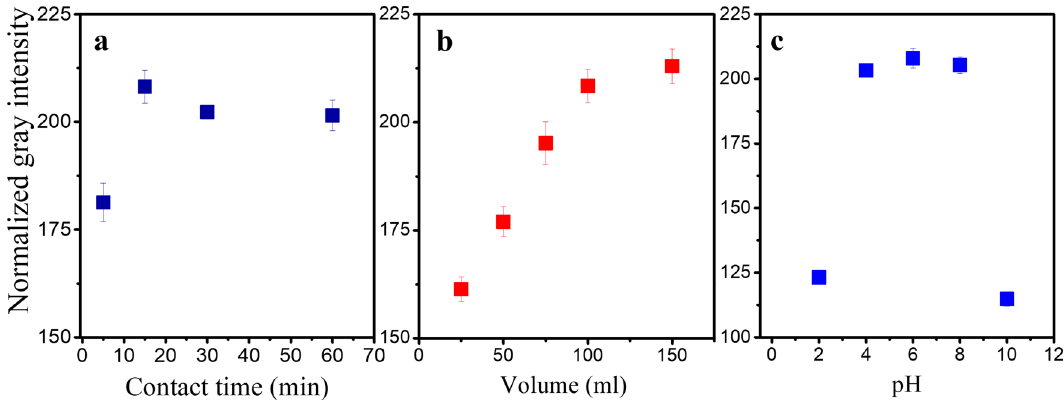
Figure 4. ( a ) Effect of contact time ( b ) Effect of sample volume ( c ) Effect of pH on preconcentration of chromium(VI) ions and its subsequent detection measured as normalized gray